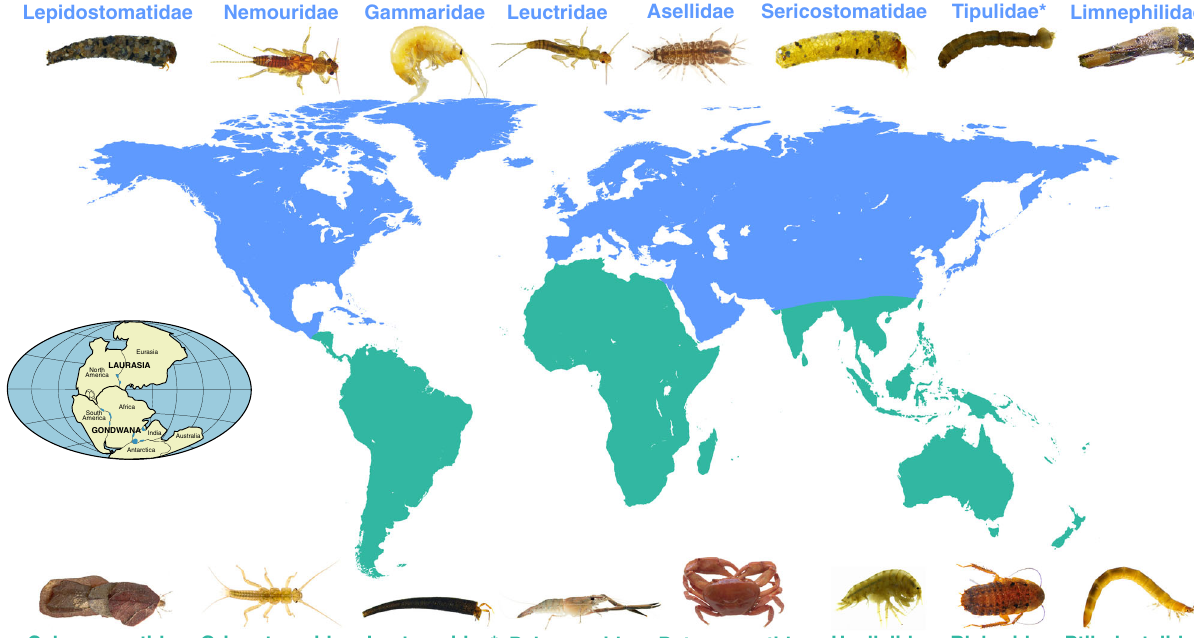
Fig. 5 Distribution of detritivore families in our study, which was predominantly Laurasian (blue) or Gondwanan (green); insert indicates origins of those two regions ( ≈ 200 Ma). Photographs represent a subset of families (ordered left to right from the most to the least abundant in our study) and asterisks denote families that were globally distributed but more abundant in one of the two areas. A complete list of families is provided in Supplementary Table 1. Photograph credits: L. Boyero, A. Cornejo, R. Figueroa, N. López-Rojo, F. Masese, J. Pérez, J. Rubio-Ríos, J. Vieira and C. M.